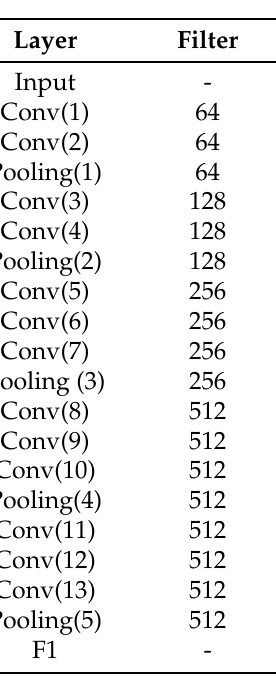
Table 1. Description of the selected model.